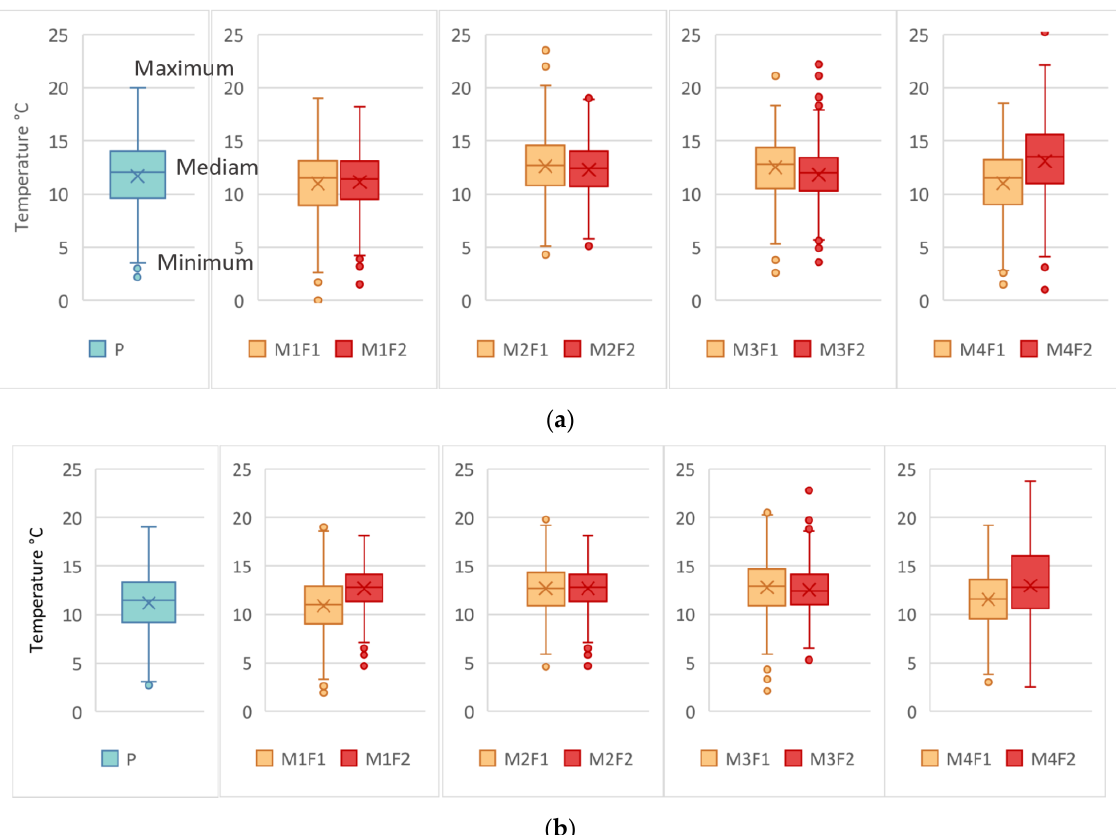
Figure 8. Distribution of daily amplitude of the diurnal temperature cycle in the summer months in present (blue), near (orange), and far (red) future scenarios in Climate zones I ( a ) and II ( b ). The quartile, median, maximum, and minimum value of daily temperature amplitude points divided sorted datasets into four equal groups.